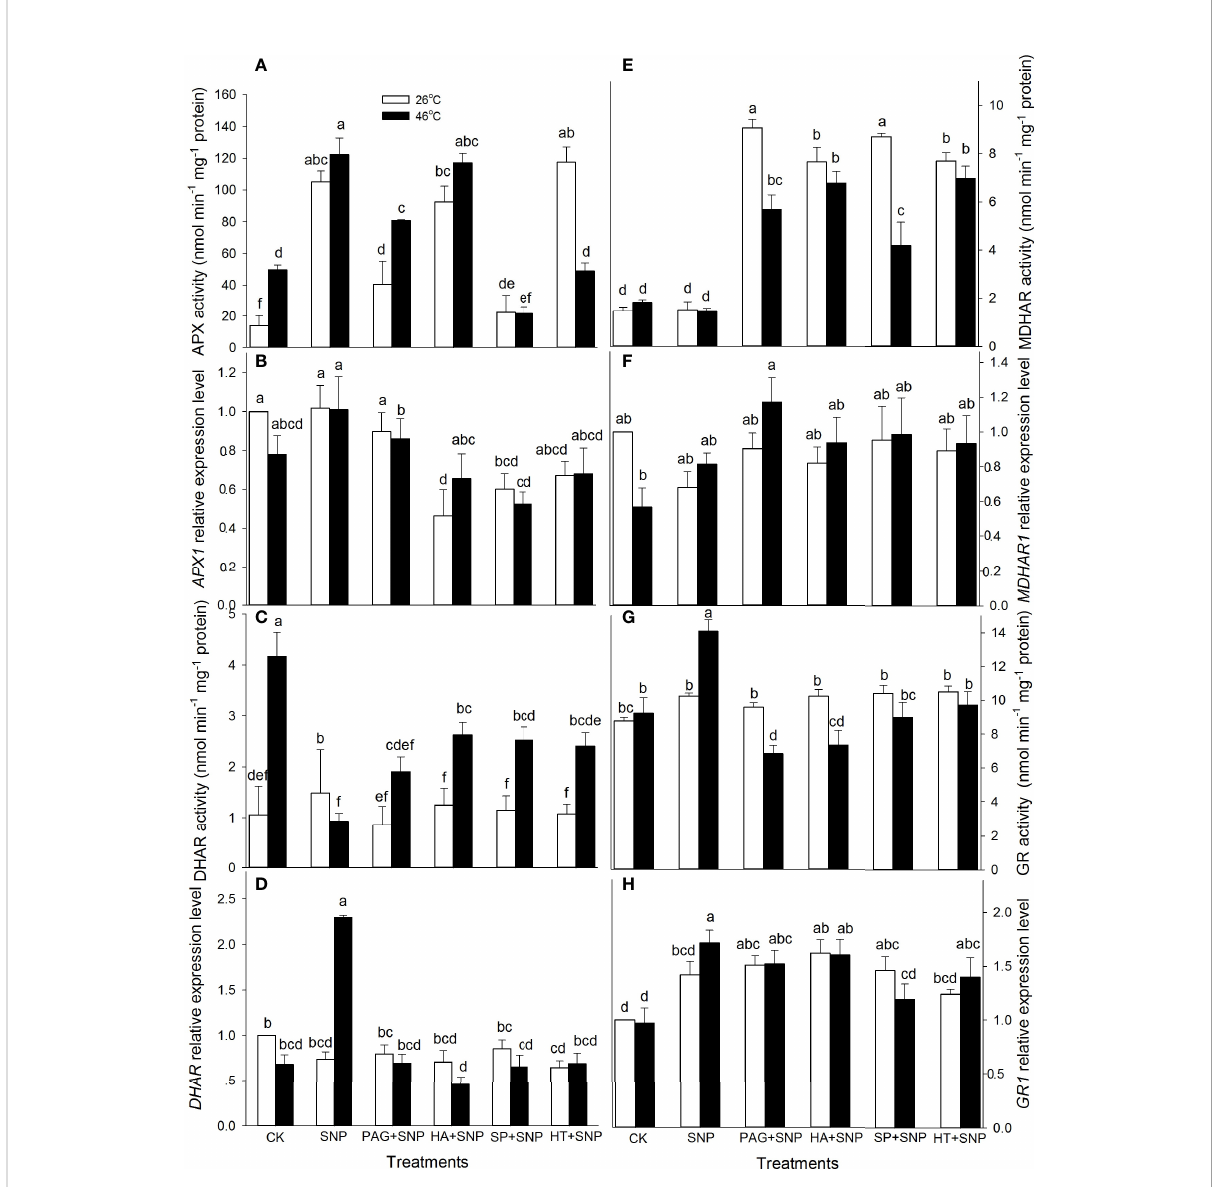
FIGURE 4 Effect of SNP alone or in combination with hydrogen sul fi de (H 2 S) inhibitors and scavengers on ascorbate peroxidase (APX) (A) , dehydroascorbate reductase (DHAR) (C) , monodehydroascorbate reductase (MDHAR) (E) , and glutathione reductase (GR) (G) activities and corresponding gene expression (B, D, F, H) in maize seedlings under non-HS and HS conditions. The data had at least three biological replicates and were tested using Duncan's multiple-range test at 0.05 signi fi cant level, which denote means ± standard error (SE). The bars with the different letters represent signi fi cant differences, while the same letters represent no signi fi cant